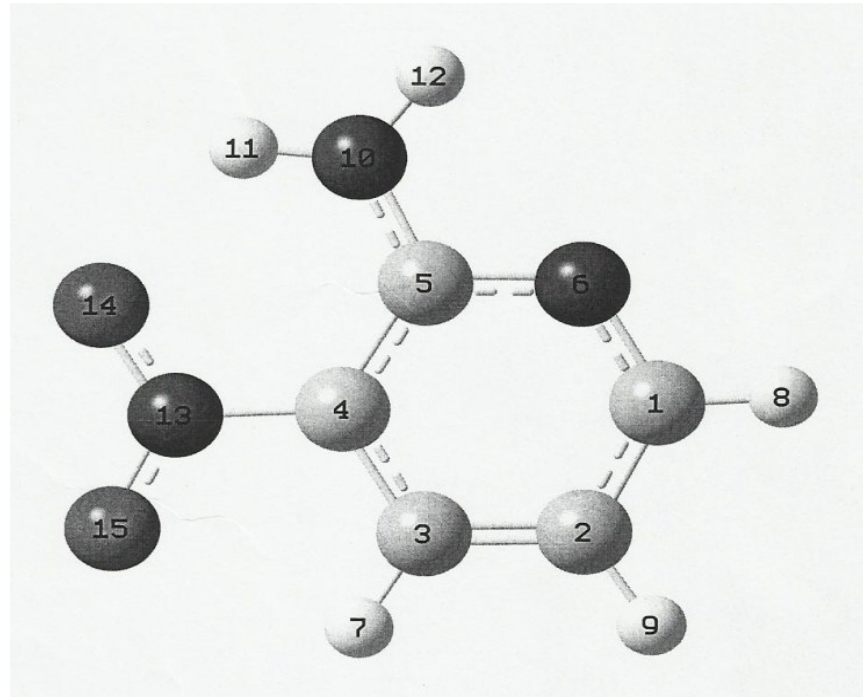
Figure 1. Optimized structure of